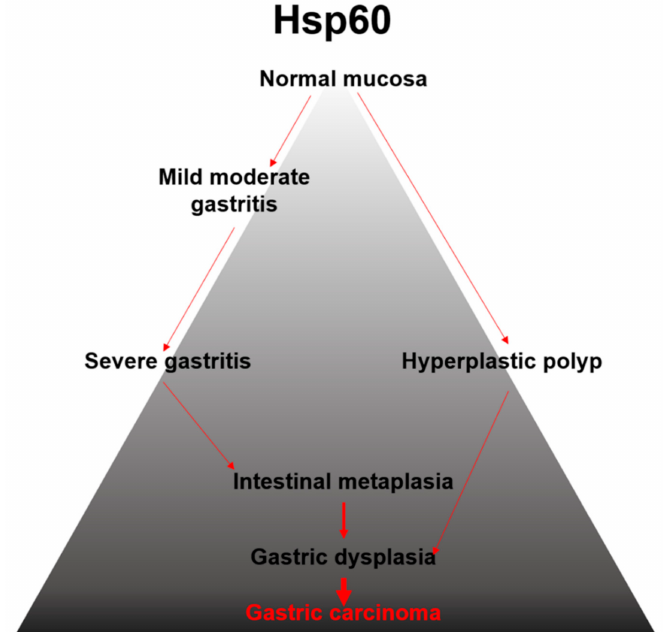
Figure 5. Schematic image visualizing the progressive increase in the number of Hsp60-positive ep- ithelial cells in gastric mucosa as measured in this work. The increase is represented by the increment in darkness from top (lower proliferation) to bottom (higher proliferation), during the progression from normal mucosa ( top ) toward gastric carcinoma ( bottom ), passing through intermediate stages, such severe gastritis, hyperplastic polyp, intestinal metaplasia, and gastric